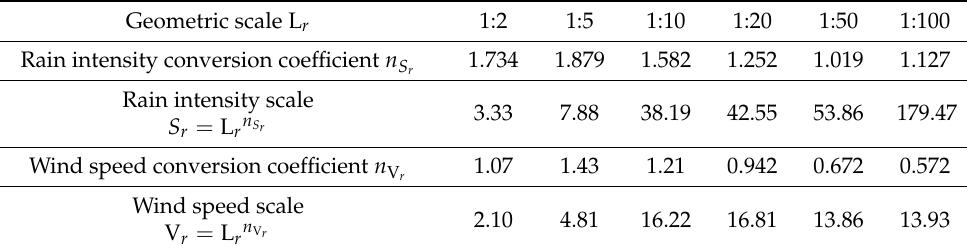
Table 1. Conversion coefficient n between the atomized rain intensity and wind